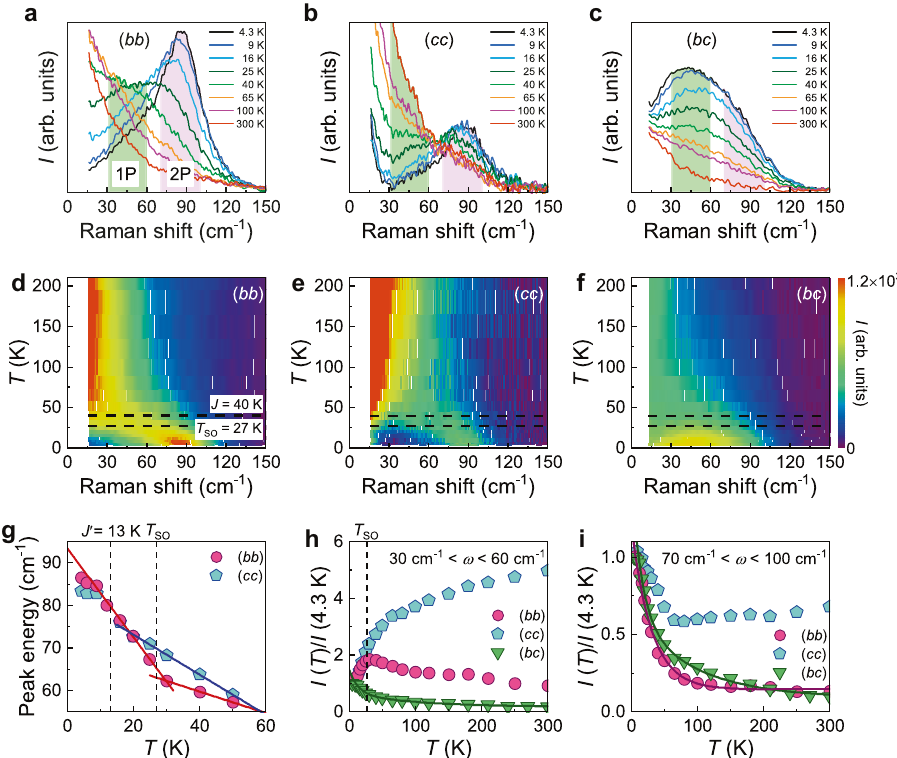
Fig. 3 Temperature evolution of magnetic excitations. a – c Temperature dependence of the magnetic Raman continuum in ( bb ), ( cc ), and ( bc ) polarizations. The green and pink shadings mark the characteristic energy scales of one-pair and two-pair spinon – antispinon excitations. d – f Color plots of the magnetic Raman intensity in the T - ω plane. The horizontal dashed lines indicate the onset of short-range ordering T SO = 27 K and the intrachain interaction J . g Peak energy of the two-pair spinon – antispinon continuum as a function of temperature for ( bb ) and ( cc ) polarizations. The solid lines are linear guides to the eye. The vertical dashed lines mark T SO and the interchain interaction J ′ . h , i Temperature dependence of the integrated magnetic Raman intensity over the one-pair spinon-antispinon energy of ω = 30 – 60 cm − 1 and the two-pair spinon-antispinon energy of ω = 70 – 100 cm − 1 . The solid lines are fi ts to an exponential function.